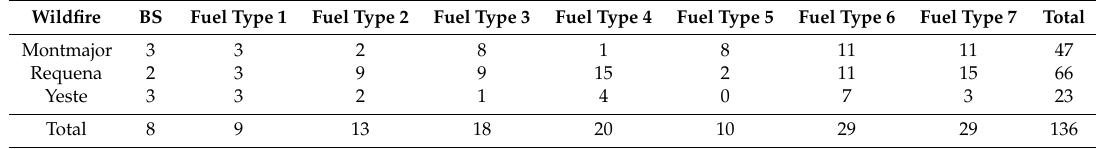
Table 2. Number of plots per fuel type collected during the field campaigns in 2017 and 2018. Fuel type refers to Prometheus fuel type. BS stands for bare